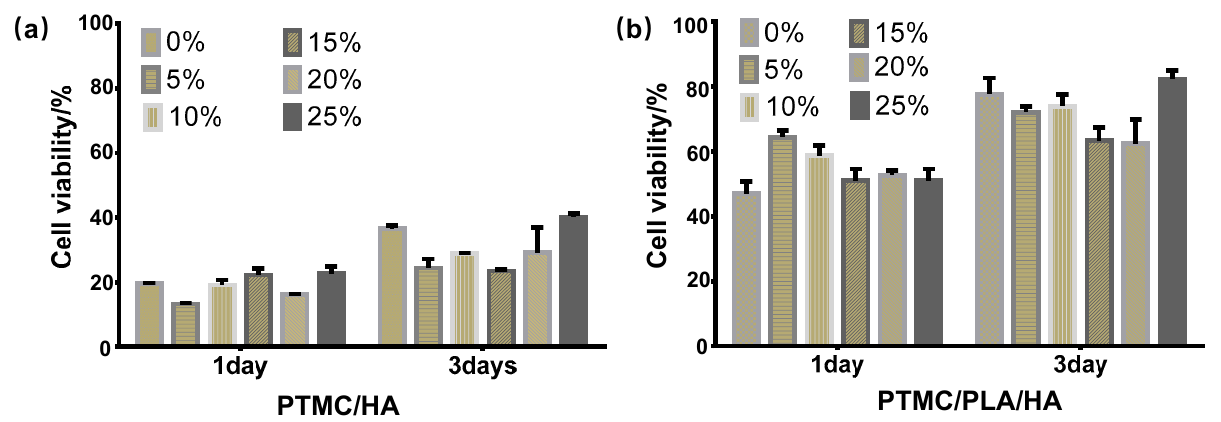
Figure 7. Cell proliferation assays of the osteoblast cells MC3T3-E1. ( a ) PTMC/HA scaffolds containing 0%, 5%, 10%, 15%, 20%, and 25% HA content, ( b ) PTMC/PLA/HA scaffolds containing 0%, 5%, 10%, 15%, 20%, and 25% HA content.